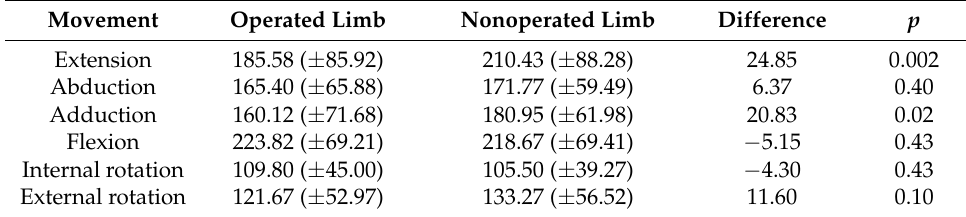
Table 2. Muscle strength in both limbs in